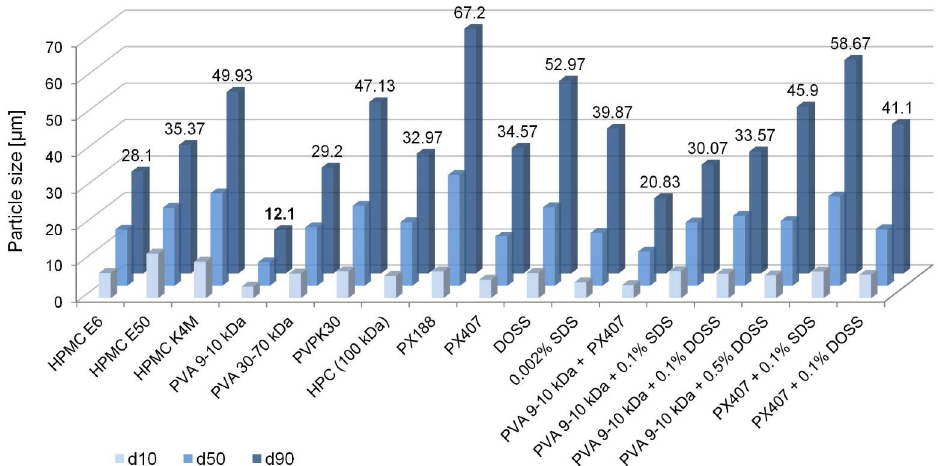
Figure 2. Particle size distribution values of cilostazol precipitated from 10% DMSO with different stabilizers during screening stage. Unless otherwise noted, stabilizer concentration was 0.5% w / v in antisolvent phase.